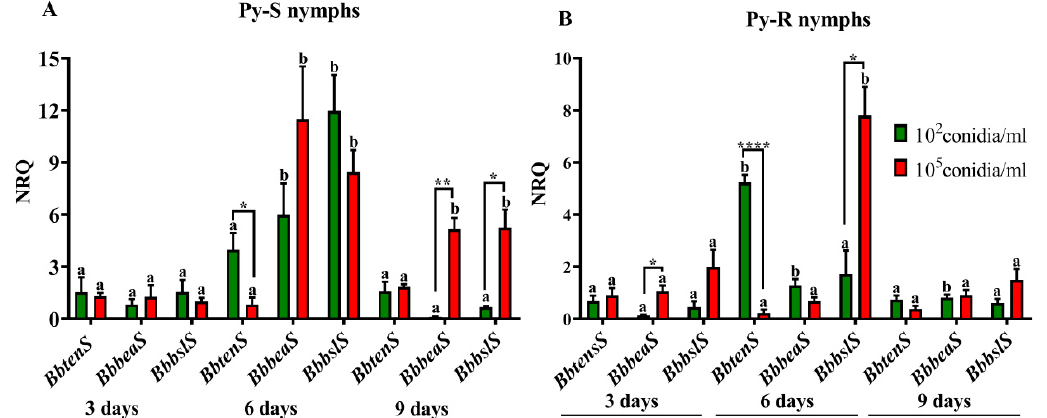
Figure 5. Normalized relative quantities (NRQ) of Beauveria bassiana transcripts encoding tenellin ( BbtenS ), beauvericin ( BbbeaS ) and bassianolide ( BbbslS ) synthetases into fourth instar nymphs of pyrethroid-susceptible ( A ) and pyrethroid-resistant ( B ) Triatoma infestans at different time periods after insect immersion in conidial suspensions. Values are means of three replicates ± SEM. Different letters indicate significant differences for a single gene through time. Asterisks indicate significant differences in gene expression at each time point. * p < 0.05; ** p ˂ 0.005; **** p ˂ 0.00005.